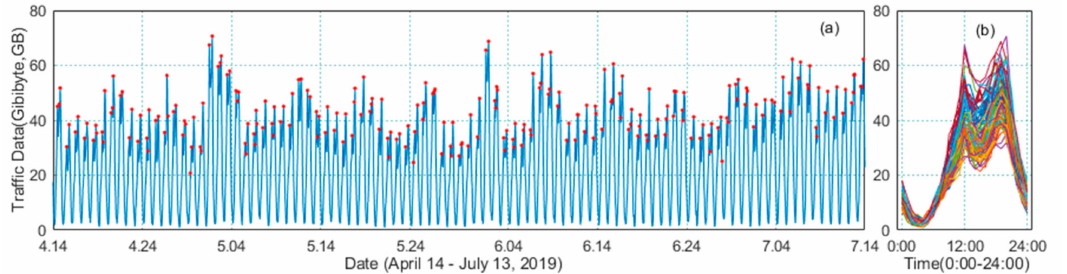
Figure 2. Base station data of Wanda Plaza. ( a ) Data curve for April 14–July 13. ( b ) Daily tra ffi c